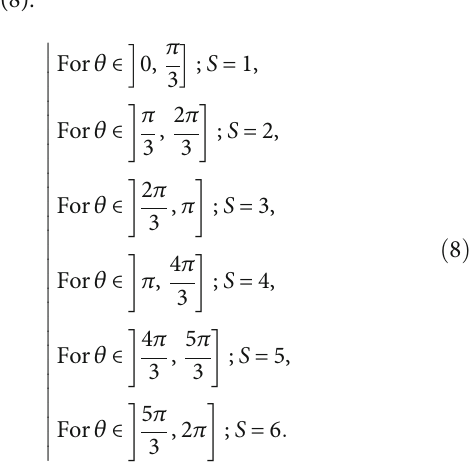
V V a , b , c ) and spectrum of line